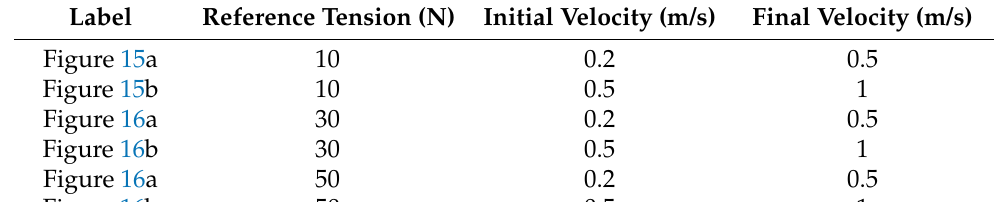
Table 5. Speed and tension parameters.